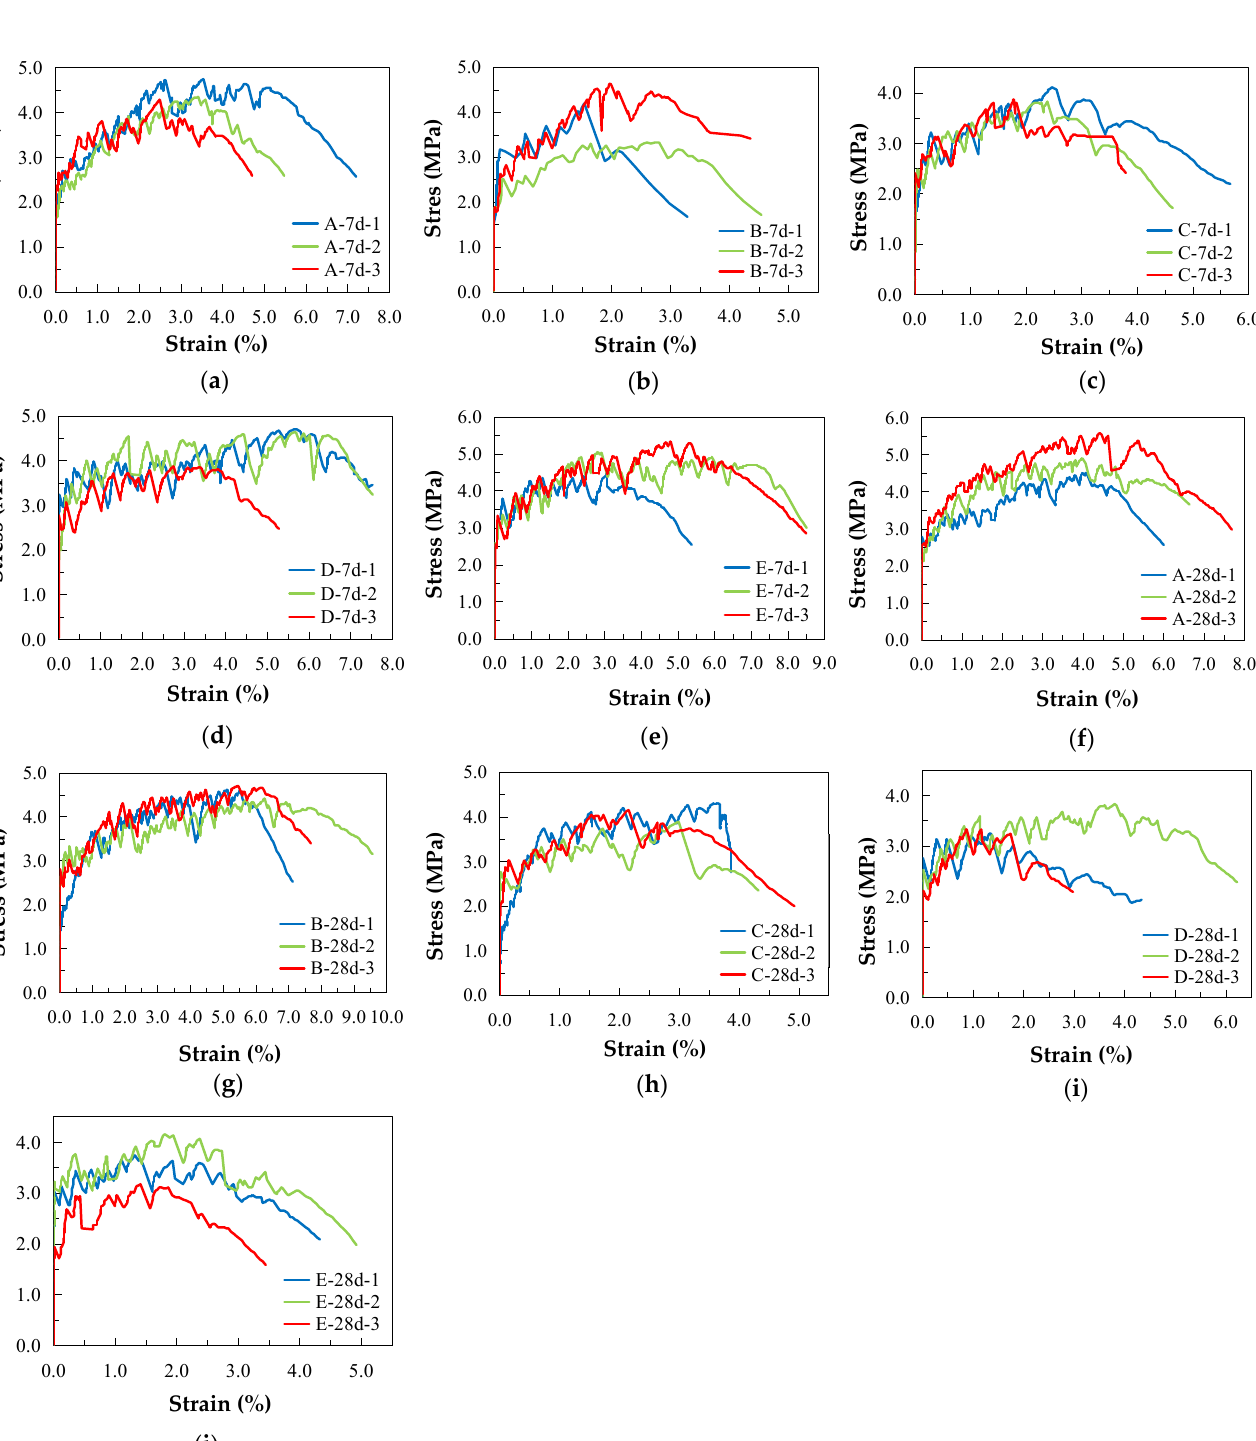
Figure 11. Uniaxial tensile stress–strain curve of ECCs with different sand sizes and ages: ( a ) Group A-7d; ( b ) Group B-7d; ( c ) Group C-7d; ( d ) Group D-7d; ( e ) Group E-7d; ( f ) Group A-28d; ( g ) Group B-28d; ( h ) Group C-28d; ( i ) Group D-28d; ( j ) Group E-28d.